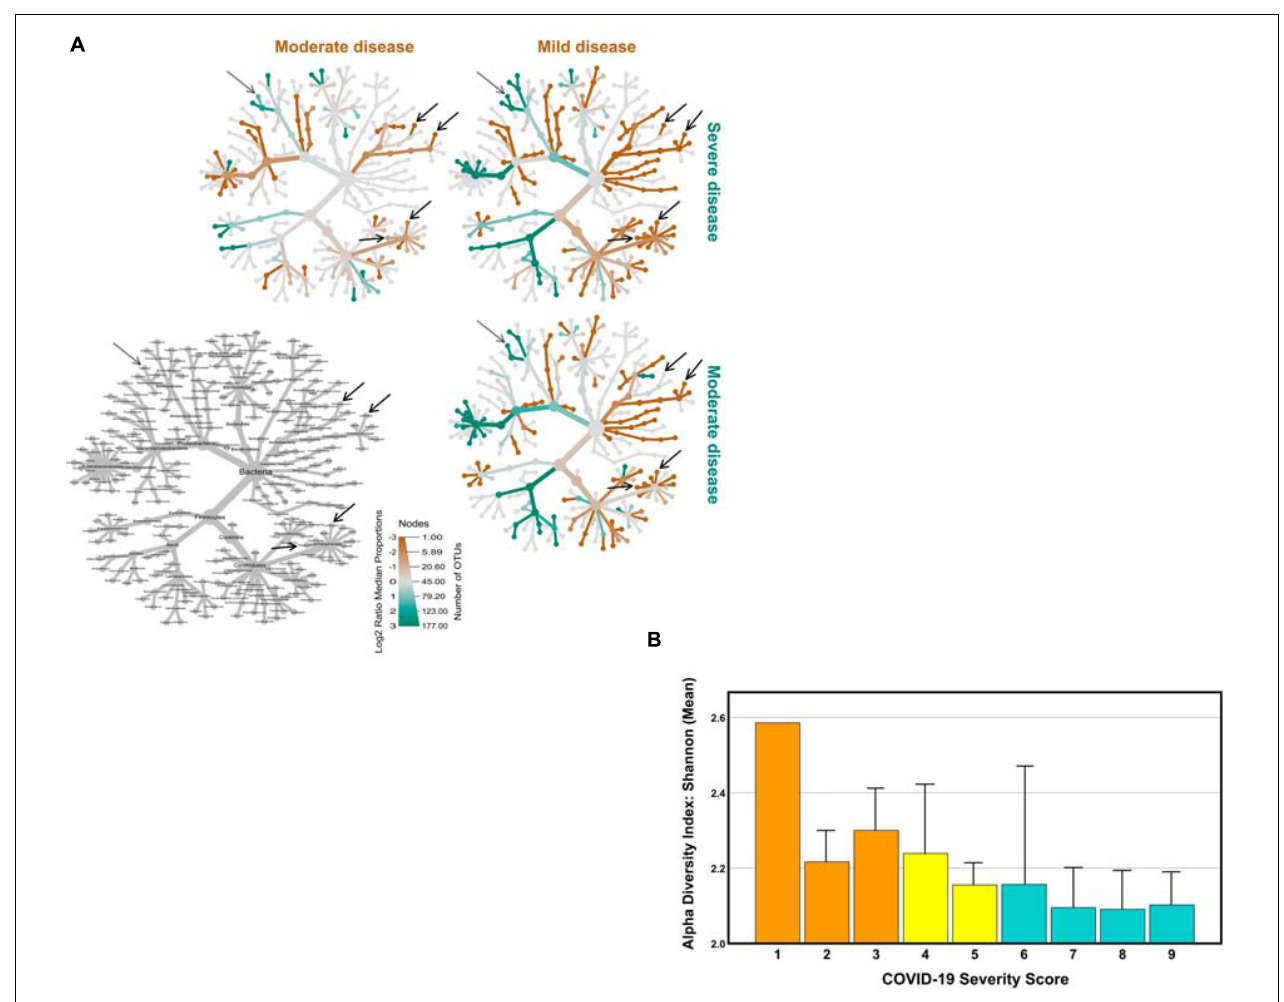
FIGURE 1 | Comparison of coronavirus disease 2019 (COVID-19) gut microbiome with COVID-19 severity. Disease severity was determined according to the WHO Clinical Progression Scale: mild, moderate, and severe. (A) Heat tree visualization of the taxonomic differences between the COVID-19 severity groups based on the Log2 ratio median abundance (proportions), in which the terminal nodes correspond to bacterial genera. The identification of the nodes is shown in the bottom left image. Three comparisons were done: severe ( blue green ) vs. mild ( orange ); severe ( blue green ) vs. moderate ( orange ); and, ultimately, moderate ( blue green ) vs. mild ( orange ). The dominant color corresponds to a higher number of operational taxonomic units (OTUs). The Log2 ratio is 0 ( gray ) when the compared groups are similar. (B) The Shannon diversity index (mean + SEM) of the COVID-19 patients according to the WHO Clinical Progression Scale, from score 1 (asymptomatic, viral RNA detected) to score 9 (mechanical ventilation pO 2 /FiO 2 < 150 and vasopressors, dialysis, or